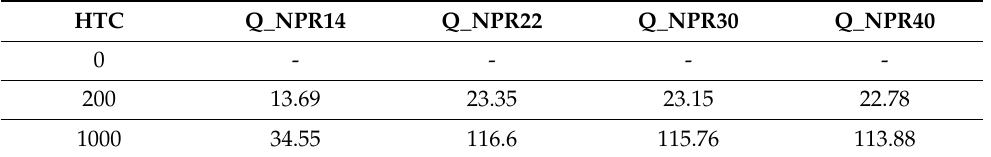
Table 5. Heat transfer rate (in W) calculated for an area behind the shock for inlet temperature = 1000